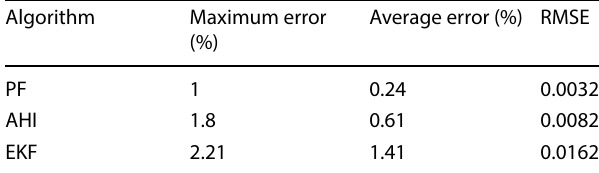
Table1 Estimation error of SOC with initial value of 1